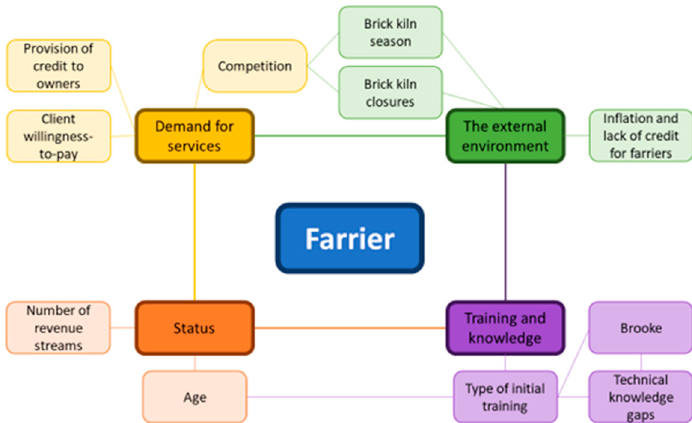
Figure 2. A conceptual framework depicting the key themes that farriers used to describe the factors influencing their work.